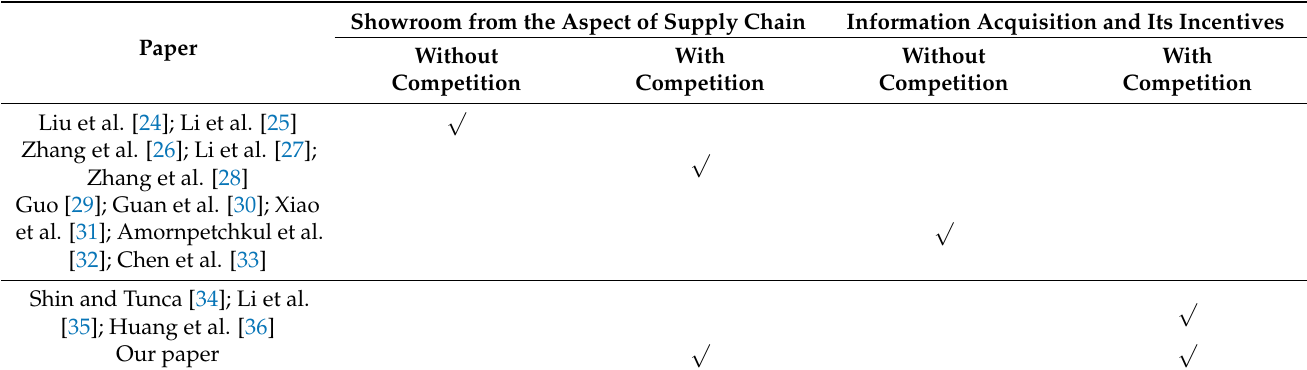
Table 1. Comparison among our paper and the most relevant